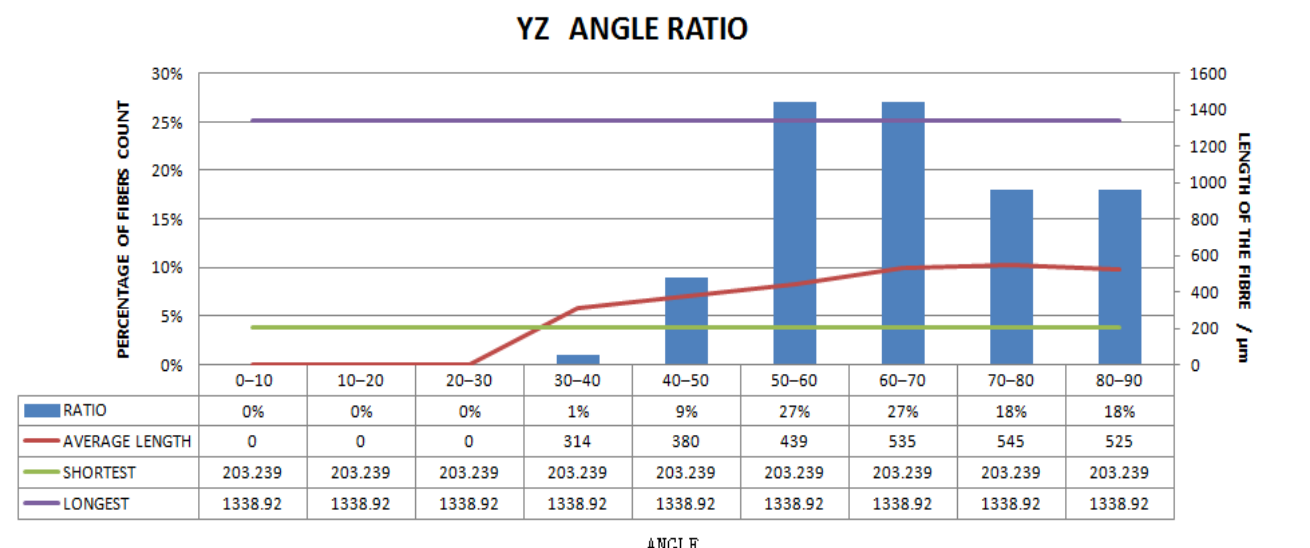
Figure 17. Statistical diagram of the angle between polyester short fibers reconstructed by Avizo software and the YZ direction (less than 200 microns removed).